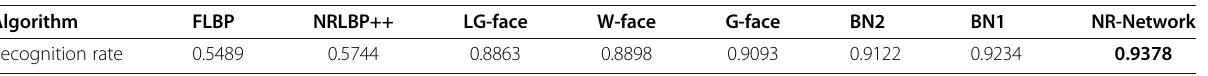
Table 7 The average recognition rates of different methods on the CMU-PIE database for face recognition under varying illumination Algorithm FLBP NRLBP++